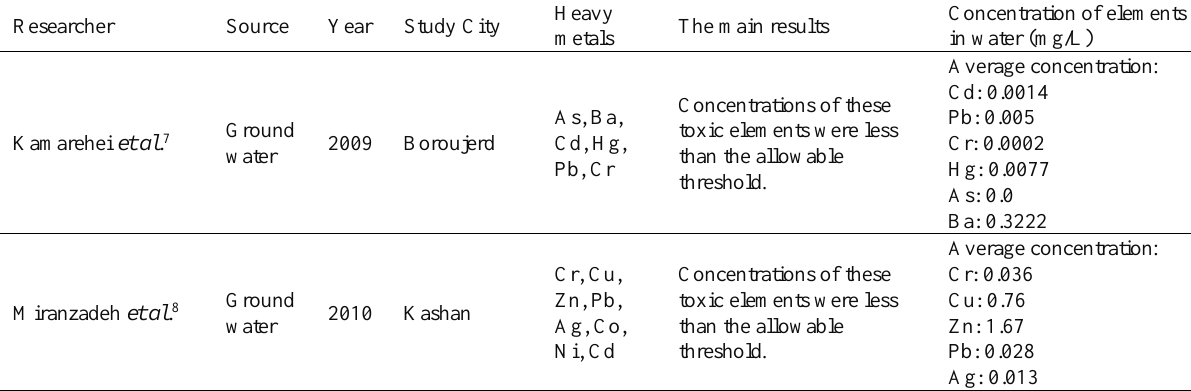
Table 2. Selected